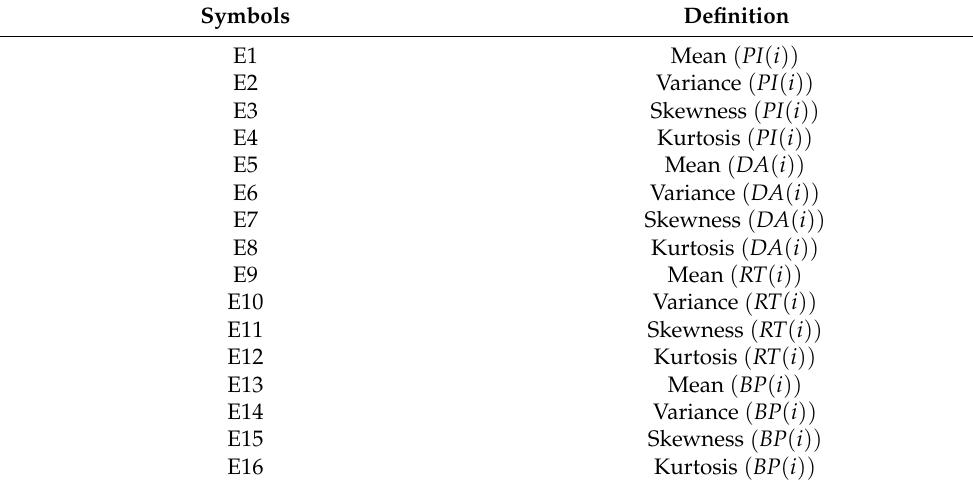
Table 3. The definitions of the 16 energy